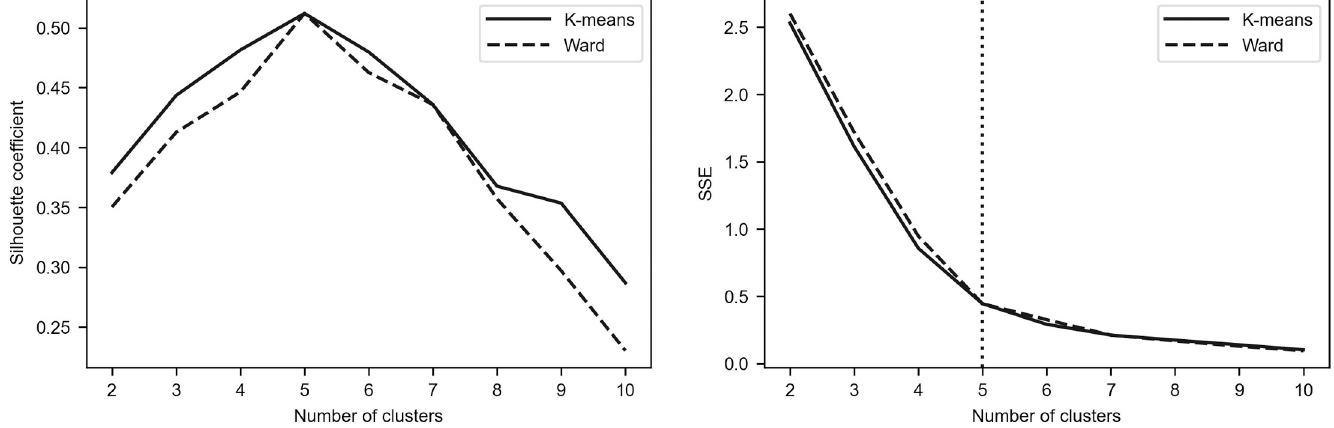
Fig 3. Silhouette coefficients and elbow curve–Period_2a.